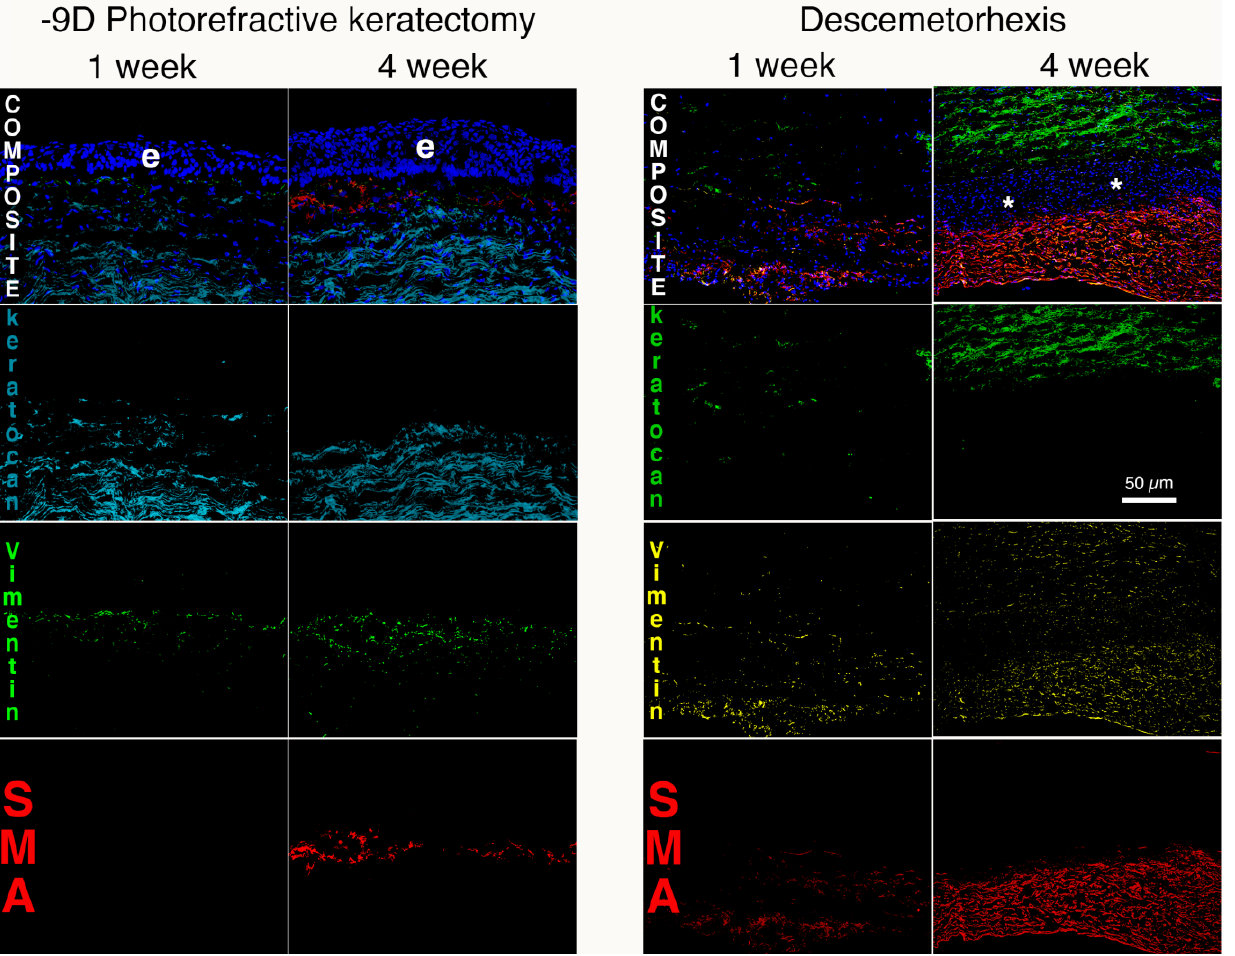
Figure 3. Mesenchymal keratocytes, corneal fibroblasts, fibrocytes and myofibroblasts in the response to corneal injury. Triplex IHC for keratocan, vimentin and α -SMA after photorefractive keratectomy (PRK) for high myopia without mitomycin C treatment or Descemetorhexis (removal of an 8 mm diameter circle of Descemet’s membrane and associated corneal endothelium. At one week after PRK, keratocan-positive keratocytes are diminished in the anterior stroma beneath the epithelium (e) and there are increased vimentin-positive, α -SMA-negative cells that are primarily corneal fibroblasts and fibrocytes (compare to Figure 2A). No α -SMA-positive myofibroblasts are present. At four weeks after PRK, the anterior stroma is populated by a mixture of α -SMA-positive, vimentin-positive myofibroblasts and α -SMA-negative, vimentin-positive, keratocan-negative corneal fibroblasts and, likely, fibrocytes. Note the epithelial (e) hyperplasia. At one week after Descemetorhexis (only the posterior stroma is shown), the injury is so severe that some α -SMA-positive myofibroblasts have already been generated and the more anterior stroma is populated with -SMA-negative, vimentin-positive, keratocan-negative corneal fibroblasts and likely fibrocytes. By four weeks after Descemetorhexis, when the corneal endothelium and Descemet’s membrane have yet to regenerate, the most posterior stroma is occupied by a dense population of α -SMA-positive myofibroblasts. Between the myofibroblast layer, and the more anterior keratocan-positive keratocyte layer, there is a layer of vimentin-positive, α -SMA-negative, keratocan-negative cells (*) that are corneal fibroblasts and residual fibrocytes. Reprinted with permission from Ref. [8]. Copyright 2021 Elsevier. Reprinted with permission from Ref. [9]. Copyright 2021